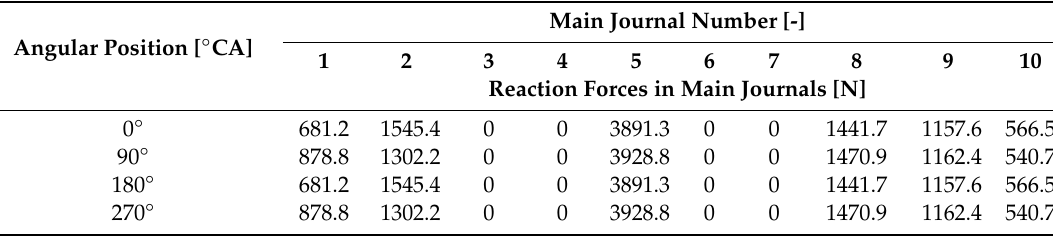
Table 1. Changes in the reaction forces at the contact of the supports with each main journal when the shaft rotation angle was changed by 90 ◦ and one of the supports (of journal no. 5 counting from the timing gear end) was o ff set upwards by 0.03 mm relative to the others.